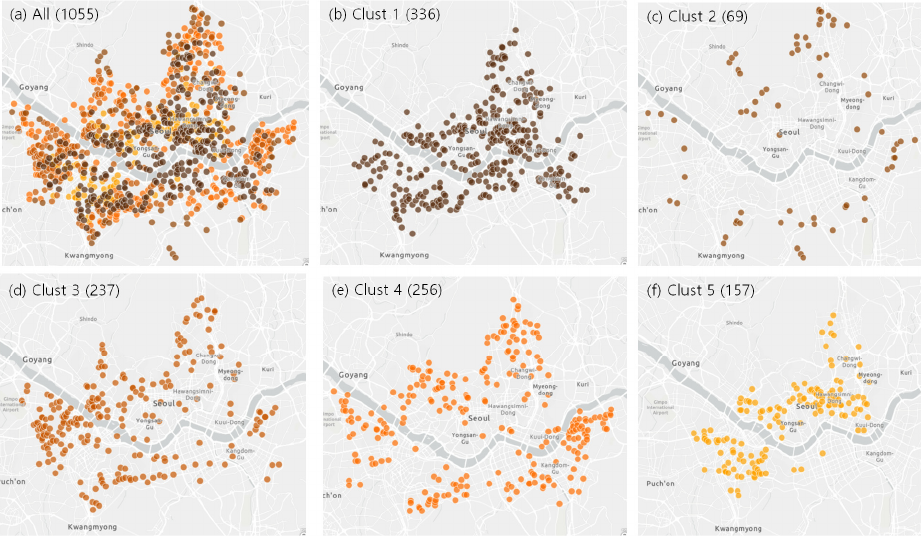
Figure 4. Location of ( a ) all stations and ( b ) Cluster 1, ( c ) Cluster 2, ( d ) Cluster 3, ( e ) Cluster 4, and ( f ) Cluster 5 stations.